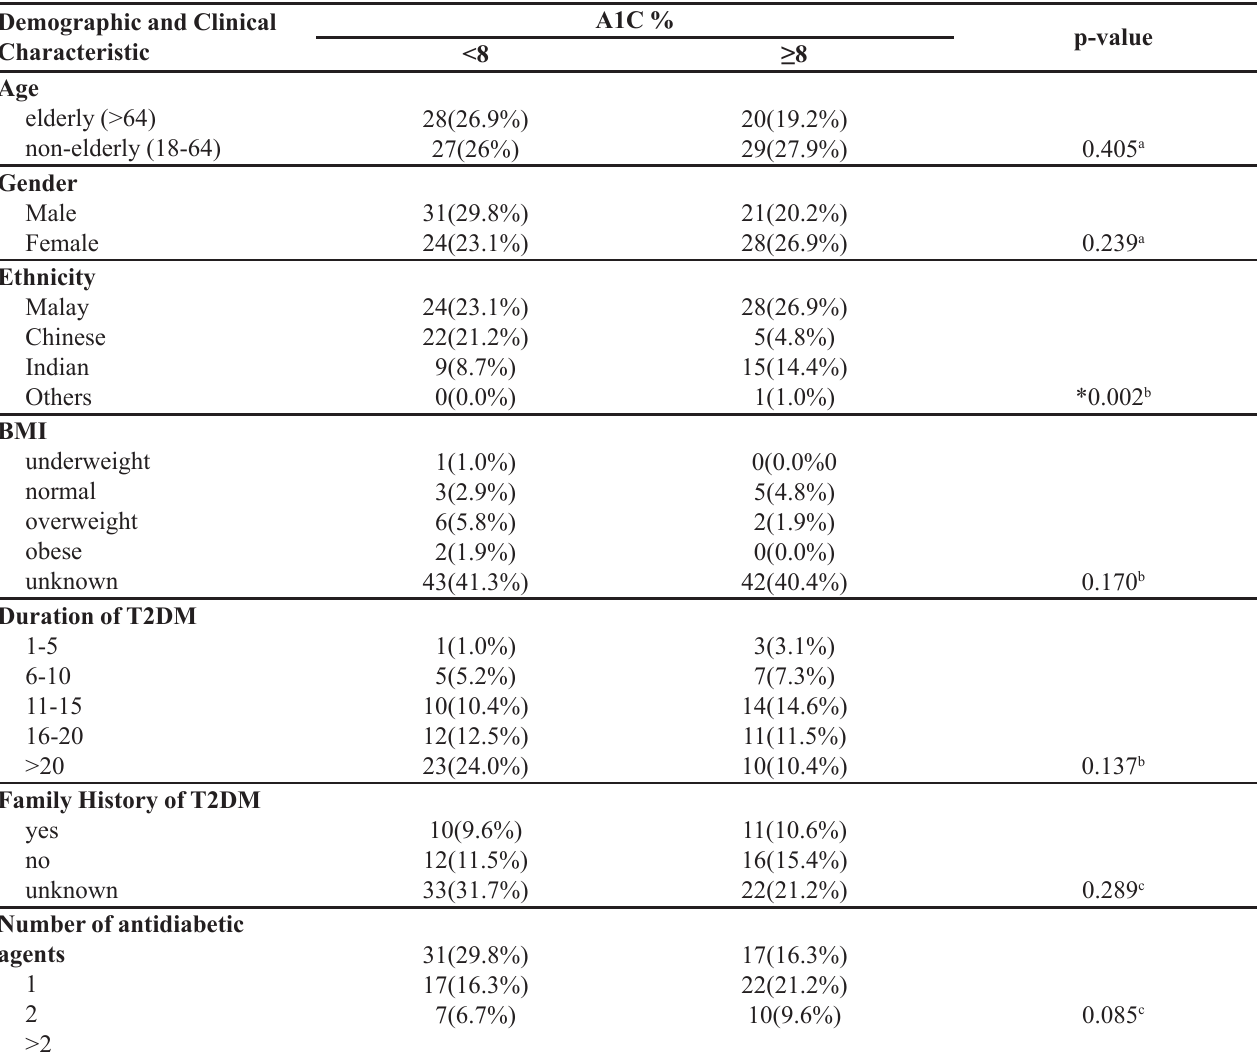
TABLE VII - Association between A1C with demographic and clinical characteristics Demographic and